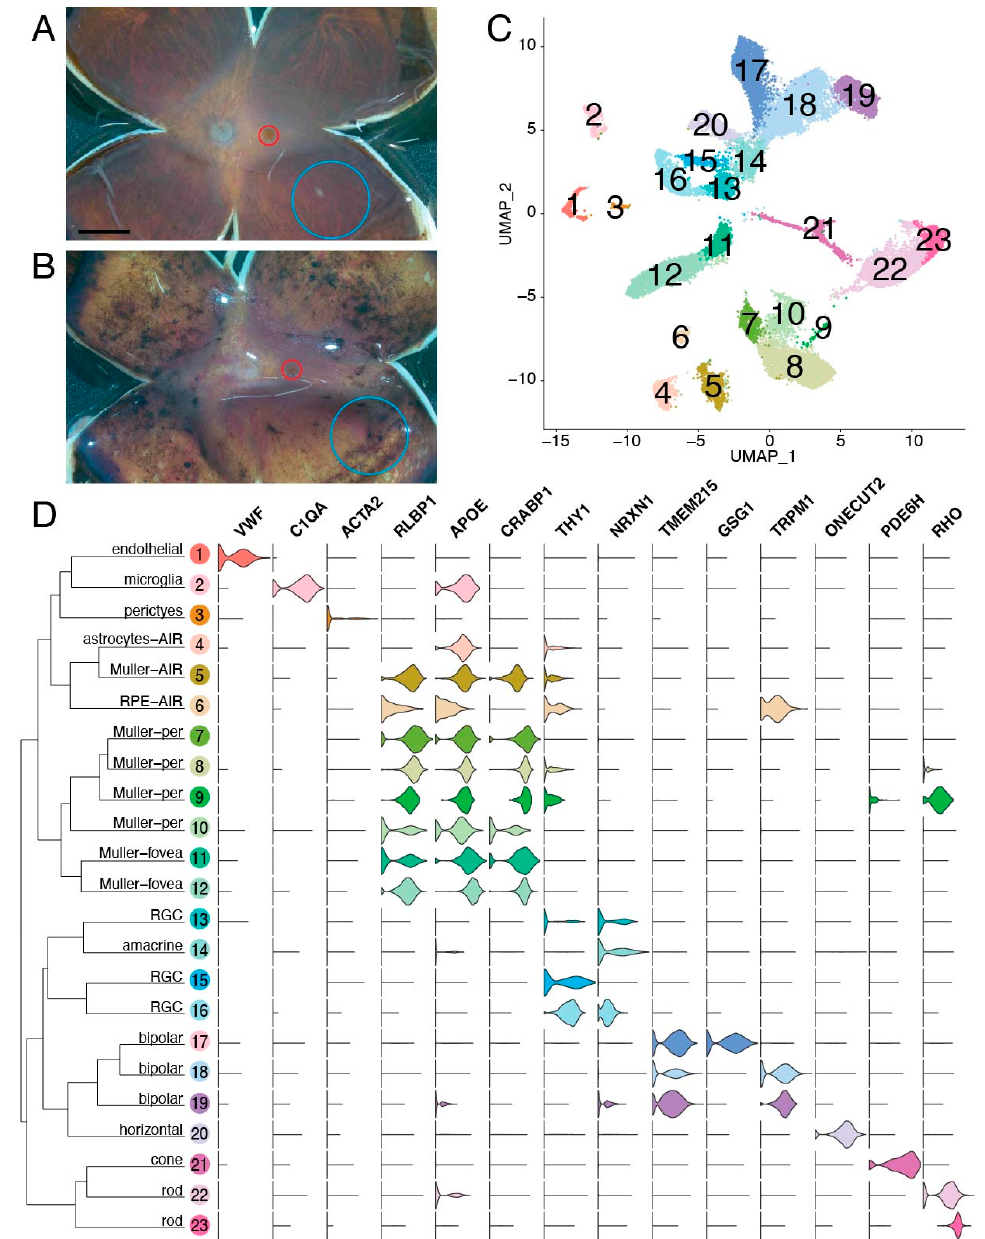
Figure 3. Single-cell RNA sequencing of the AIR donor. ( A , B ): Five human donor eyes were used for this study. A gross image of a control eye (donor 4) ( A ) and the AIR eye (donor 5) ( B ) are included. From each eye, a 2 mm foveal centered punch (red) and an 8 mm peripheral punch isolated from the inferotemporal region (blue) were acquired and gently dissociated. Scalebar ( A ) is 5 mm. ( C ): Single-cell RNA sequencing of retinal cells from the AIR donor and four control patients. A total of 23,429 cells were recovered after filtering. Unsupervised clustering of cells resulted in 23 clusters, which are visualized with uniform manifold approximation and projection (UMAP) dimensionality reduction, where each point represents the multidimensional transcriptome of a single-cell and each cluster of cells is depicted in a different color. ( D ): Violin plots depict the expression of cell-type specific genes across the 23 identified clusters. Per = peripheral retina. AIR = autoimmune retinopathy. RPE = retinal pigment epithelium. RGC = retinal ganglion cell.